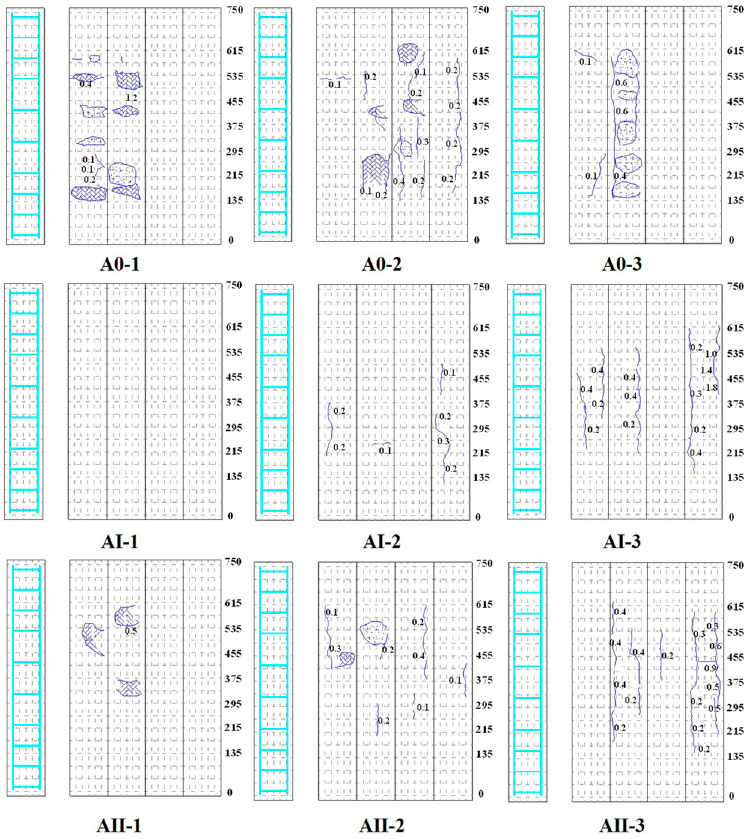
Figure 7. Cracking maps of RC column specimens. The details for the value of sustained load and duration of corrosion tests for specimens A0-1, A0-2, A0-3, AI-1, AI-2, AI-3, AII-1, AII-2, AII-3 are listed in Table 2.